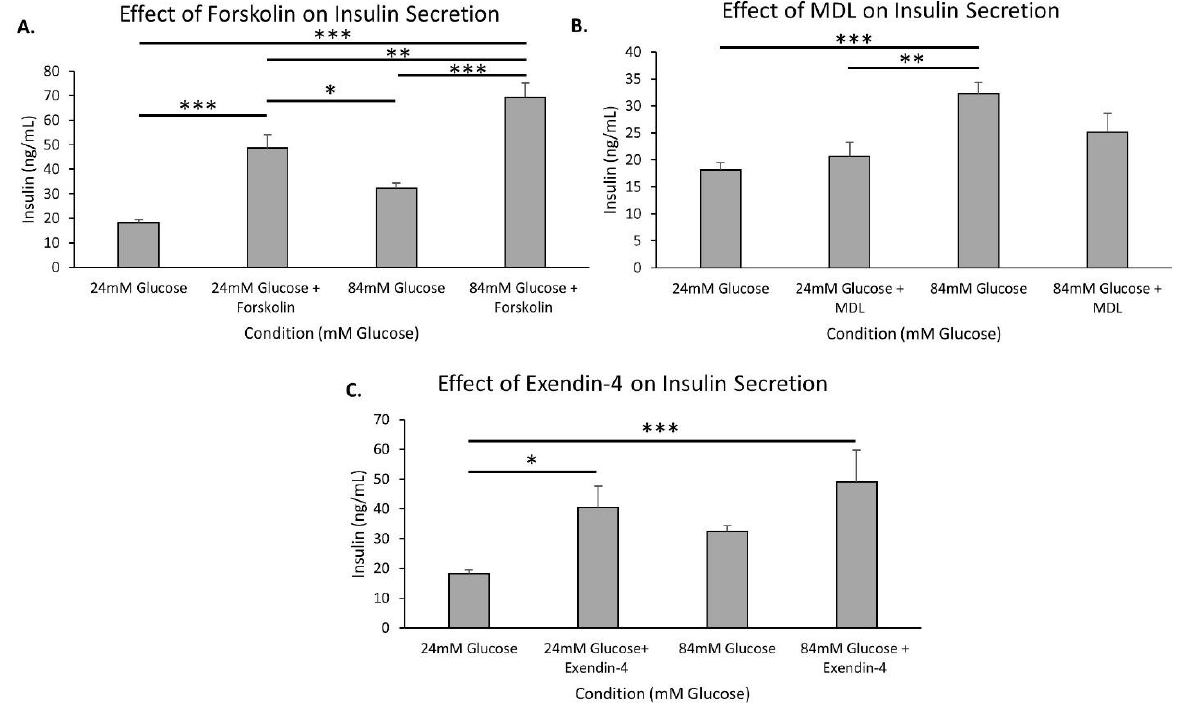
Figure 5. cAMP-related drug effect on insulin secretion in high glucose. ( A – C ) Murine islets were placed in wells containing modified KRB with 24 mM or 84 mM glucose ± mannitol balanced to 84 mM total for 1 h and then various drugs were added to each condition for 1 h of incubation before insulin was measured: 10 µM forskolin ( A ), 10 µM MDL 12,330A ( B ), and 10 nM exendin-4 ( C ) All data are presented as ± SEM. N = 5-11 replicates. * p <0.05, ** p <0.01, *** p <0.001.